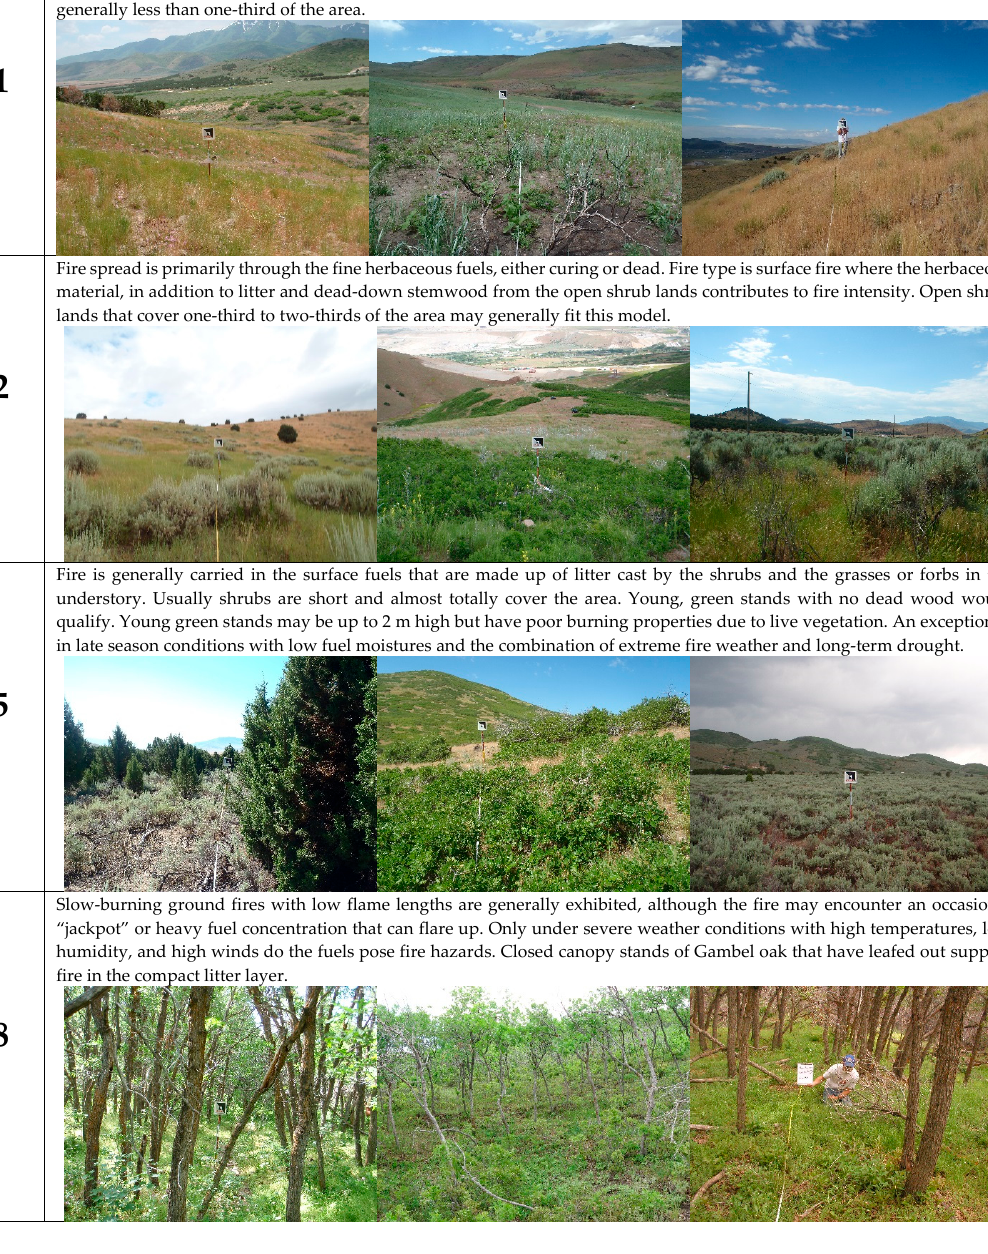
Figure A2. Typical fire behavior and representative photos associated with the primary fire behavior fuel models (FBFM) described by Anderson [32] found at Army Garrison Camp Williams.